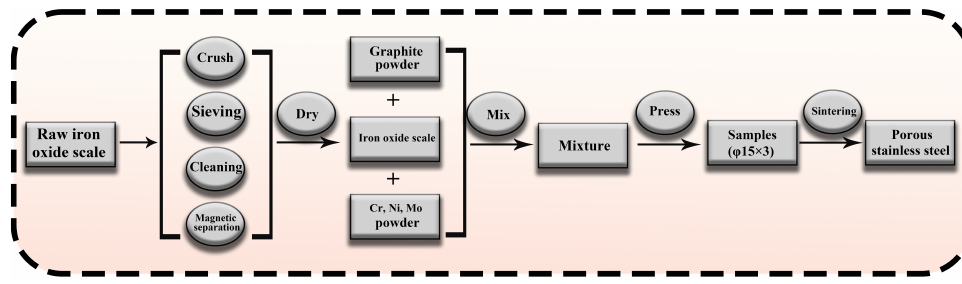
Figure 4. The preparation process of porous stainless steel.